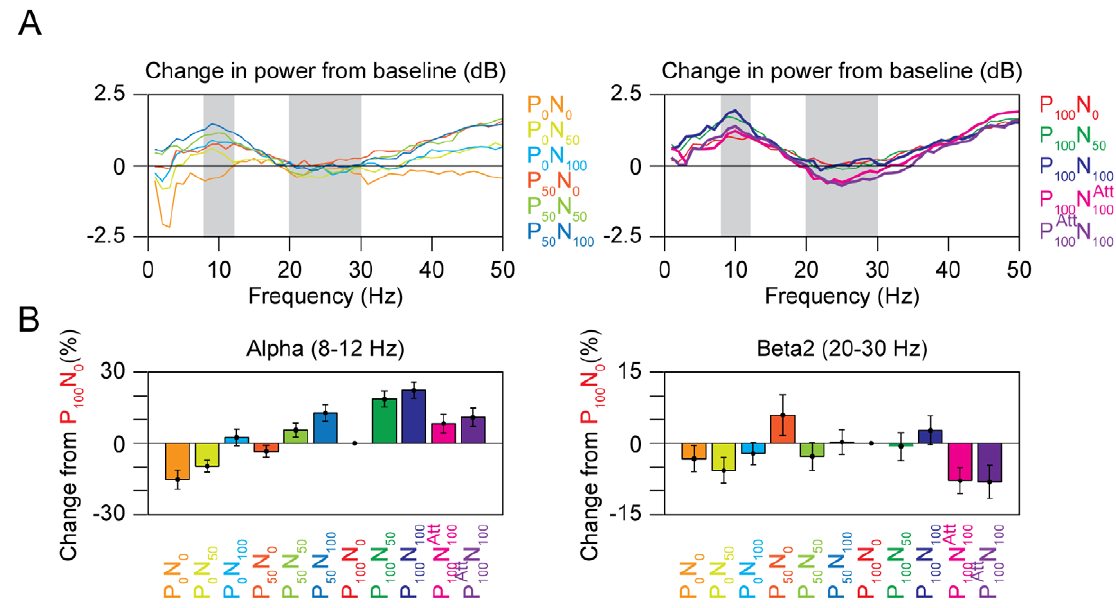
Figure 7. Effect of normalization and attention at low frequencies. (A) Change in power from baseline, for nine normalization and two attention conditions. The data are shown in two plots for clarity. Alpha and beta2 bands are shaded in gray. (B) Change in power from the P 100 N 0 condition in the alpha (left) and beta2 (right) band.